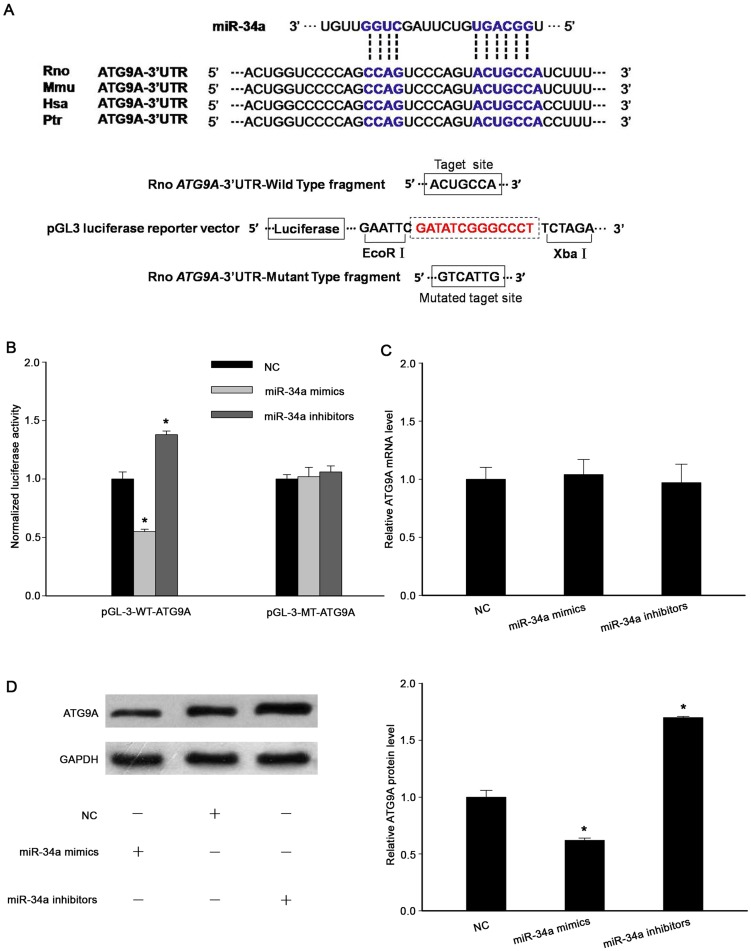
miR-34a regulation of ATG9A expression.(A) Sequence alignment between miR-34a and the 3′-UTR of ATG9A in different species and schematic diagram of construction of pGL3-ATG9A 3′-UTR-Wild Type and pGL3-ATG9A 3′-UTR-Mutant Type plasmids. (B) Luciferase assay. The report plasmid in which the luciferase coding sequence was fused to ATG9A-3′-UTR-Wild or ATG9A-3′-UTR-Mutant and miR-34a mimics, miR-34a inhibitors, and negative control were cotransfected into cardiomyocytes. Renilla luciferase activity was normalized to firefly luciferase activity. *P<0.05 compared with NC group. (C) qRT-PCR in detection ATG9A mRNA level after transfection of miR-34a mimics or inhibitor into cardiomyocytes. Expression values were normalized to the 18S housekeeping gene. *P<0.05 compared with NC group. (D) Western blot analysis of ATG9A protein after transfection of miR-34a mimics or inhibitors into cardiomyocytes. *P<0.05 compared with NC group.